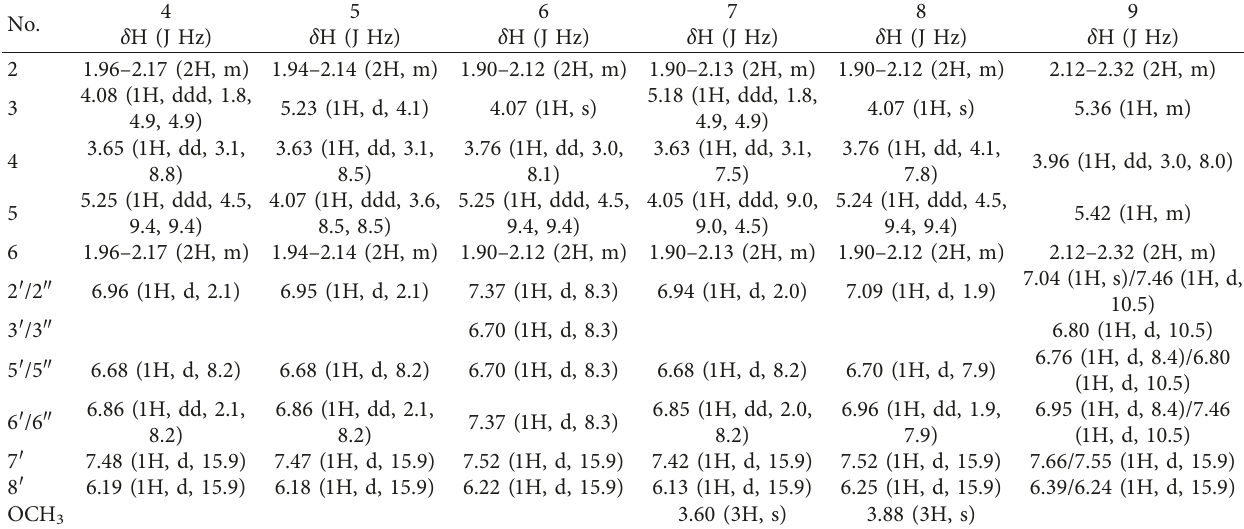
Table 2: 1 H-NMR (500 MHz, CD